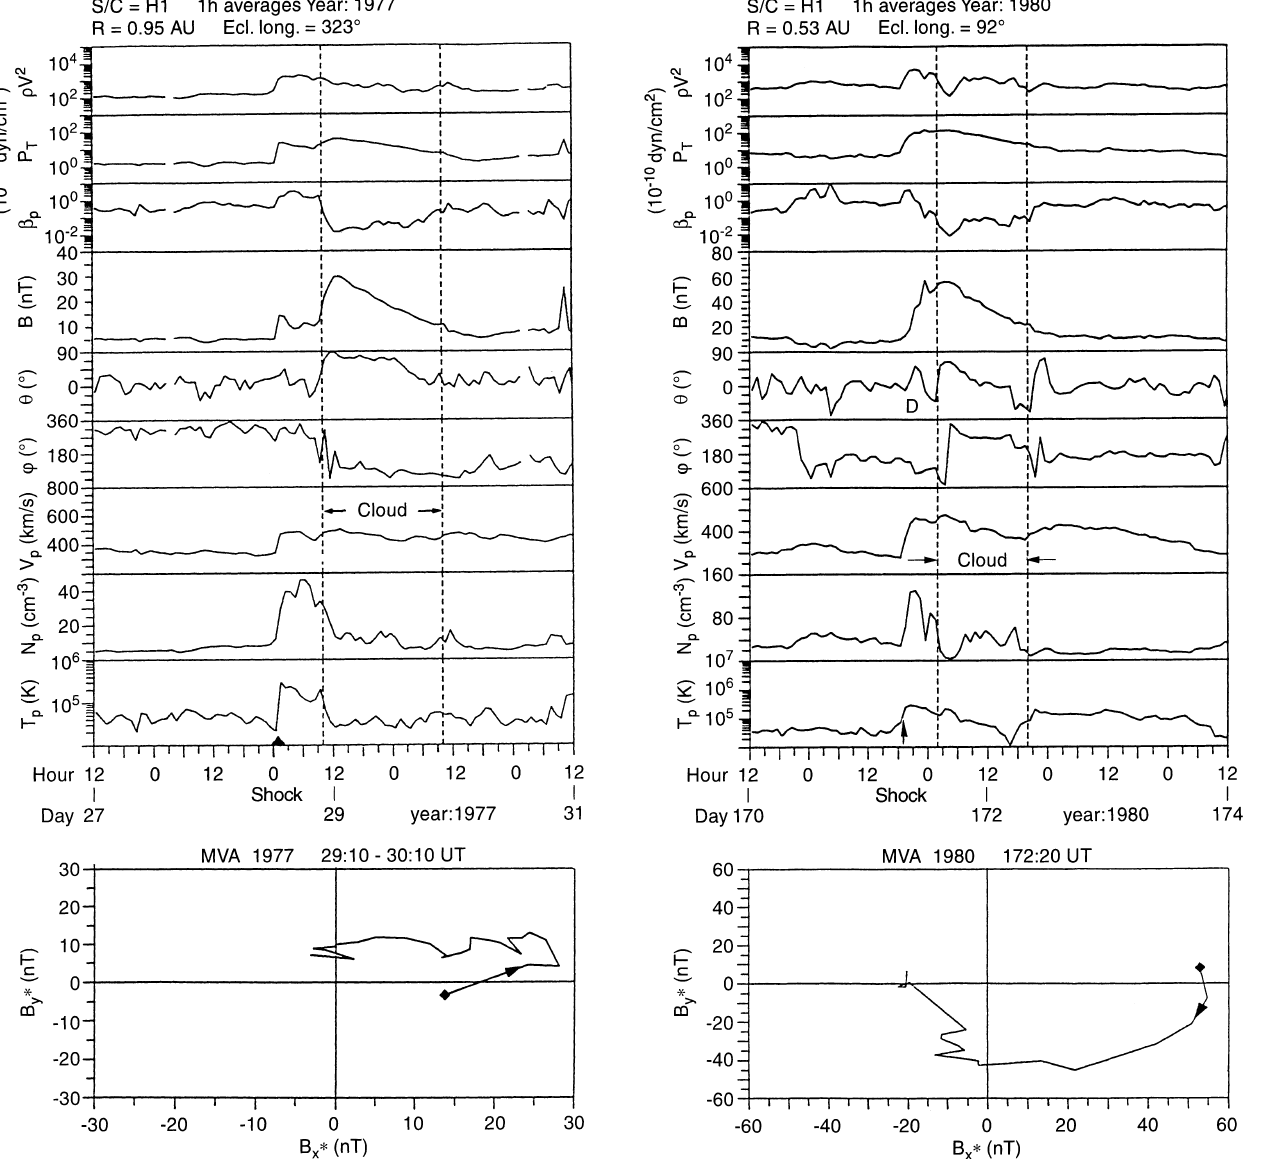
The distribution for the azimuthal axes direction of MCs in the ecliptic between 0 (cid:14) –180 (cid:14) is shown in the lower diagram of Fig. 9, also in bins of 20 (cid:14) . The axes scattered about the east-west direction, i.e., normal to the sun-spacecraft line. The average azimuthal orienta- tion of the flux tube axes was h (cid:117) i (cid:136) 91 (cid:14) , rms=44 (cid:14) , and the average orientation of the minimum variance direc- tion was h (cid:117) i (cid:136) 188 (cid:14) , rms=38 (cid:14) and h (cid:104) i (cid:136) (cid:135) 3 (cid:14) , rms=27 (cid:14) . Our findings confirm the results for IPCs and shocks found by Smith and Phillips (1997).